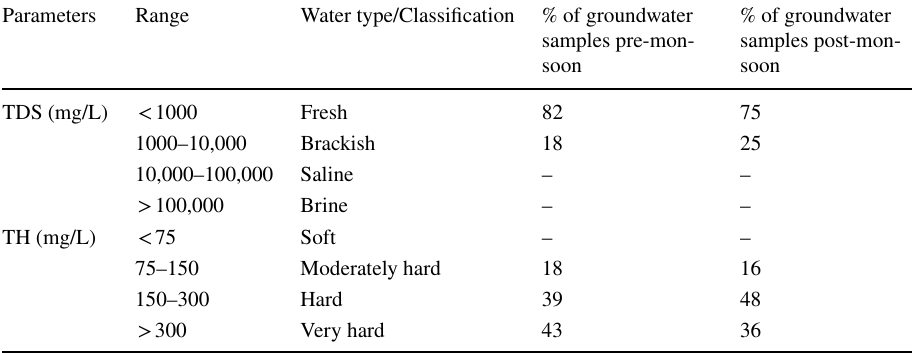
Table 4 Groundwater classifications on the basis of TDS (Freeze and Cherry 1979; Davis and Dewiest 1966) and TH (Sawyer et al.